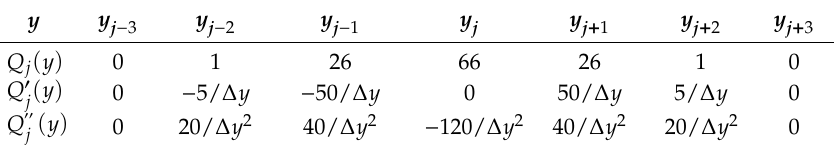
Table 2. The values of Q j ( y ) and its derivatives at nodal